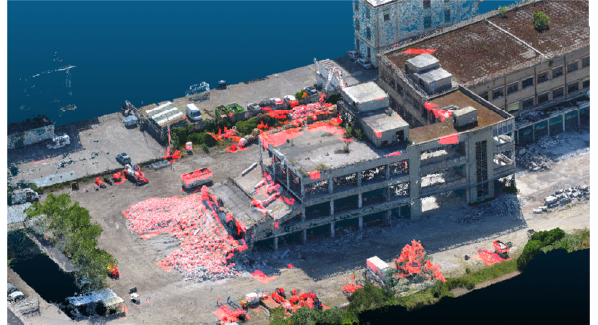
Figure 4. Point cloud representation of an INACHUS pilot structure in Lyon, France, calculated from optical imagery acquired with a low-cost commercial drone (Phantom 4, DJI), showing damage detected through machine learning